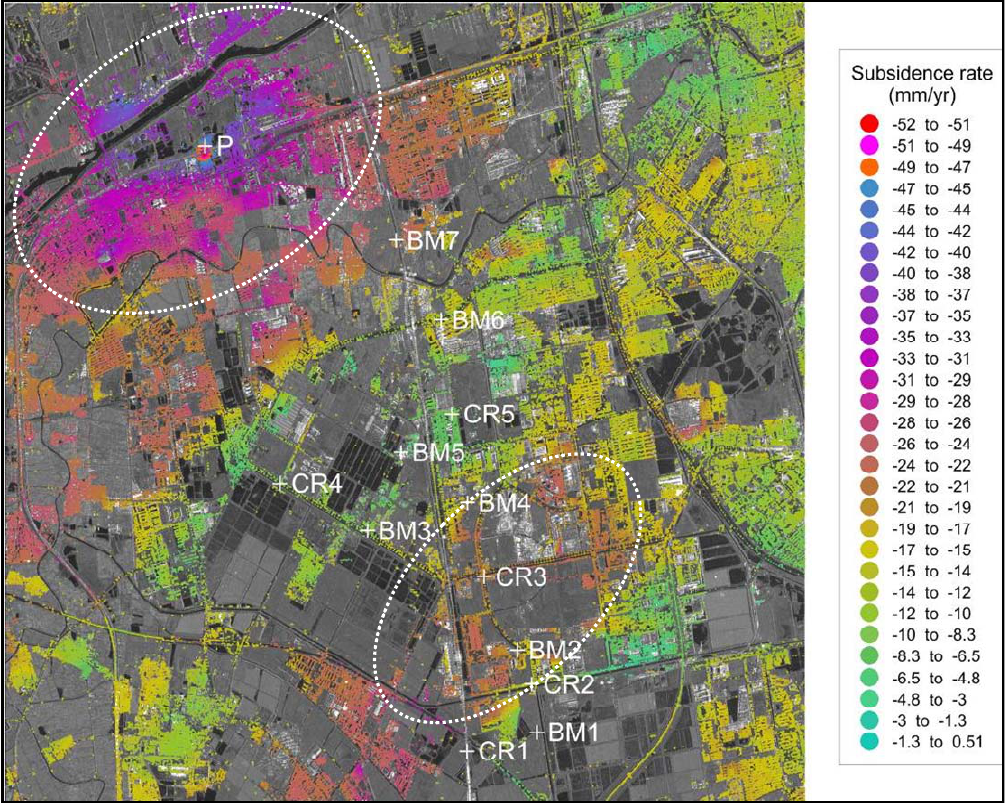
Figure 5. Subsidence rates estimated for all the valid TCPs using the 23 USB interferometric pairs. Both seven BMs and five CRs are annotated for numerical analysis. The maximum subsidence point detected in the study area is indicated by “P”. The two subsiding troughs are marked by